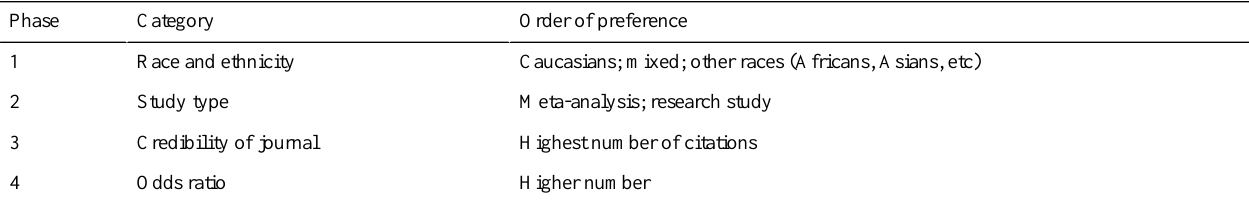
Table 1. Selection criteria for extracted associations.